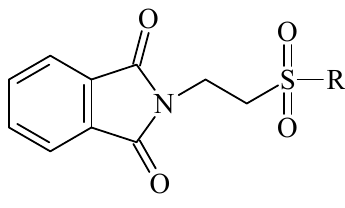
Figure 1. General structure of phthalimidoetanosulfonamide